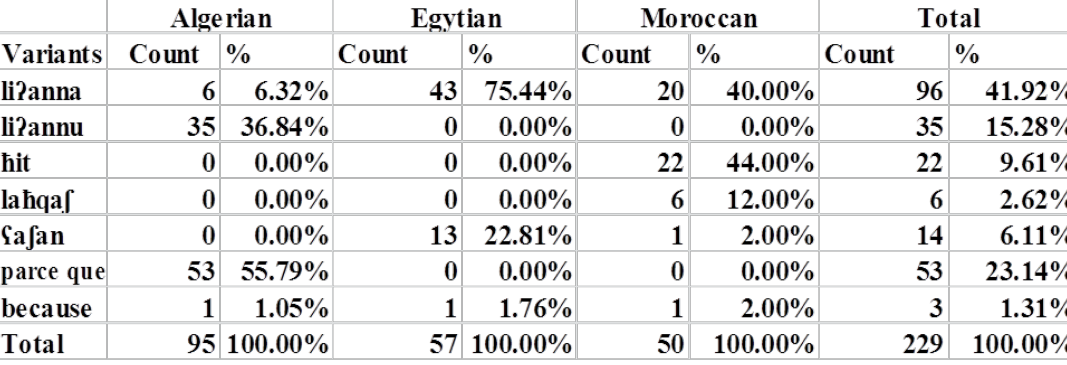
The participants from the three nationalities used a shared endoglossic causality DM liʔanna which overranked the other variants. It is no surprise that liʔanna is a shared DM as the same form is used in Standard Arabic4. In addition to liʔanna , the results show that each group has its own dialectal variants. The most frequent DM for the Algerian participants is the exoglossic DM parce que, followed by the dialectal DM liʔannu. The Egyptian participants favored the Standard endoglossic DM liʔanna , followed by ʕaʃan . As to the Moroccan participants, the dialectal DM ħit outranked the Standard form liʔanna . The Moroccan participants also used another dialectal DM